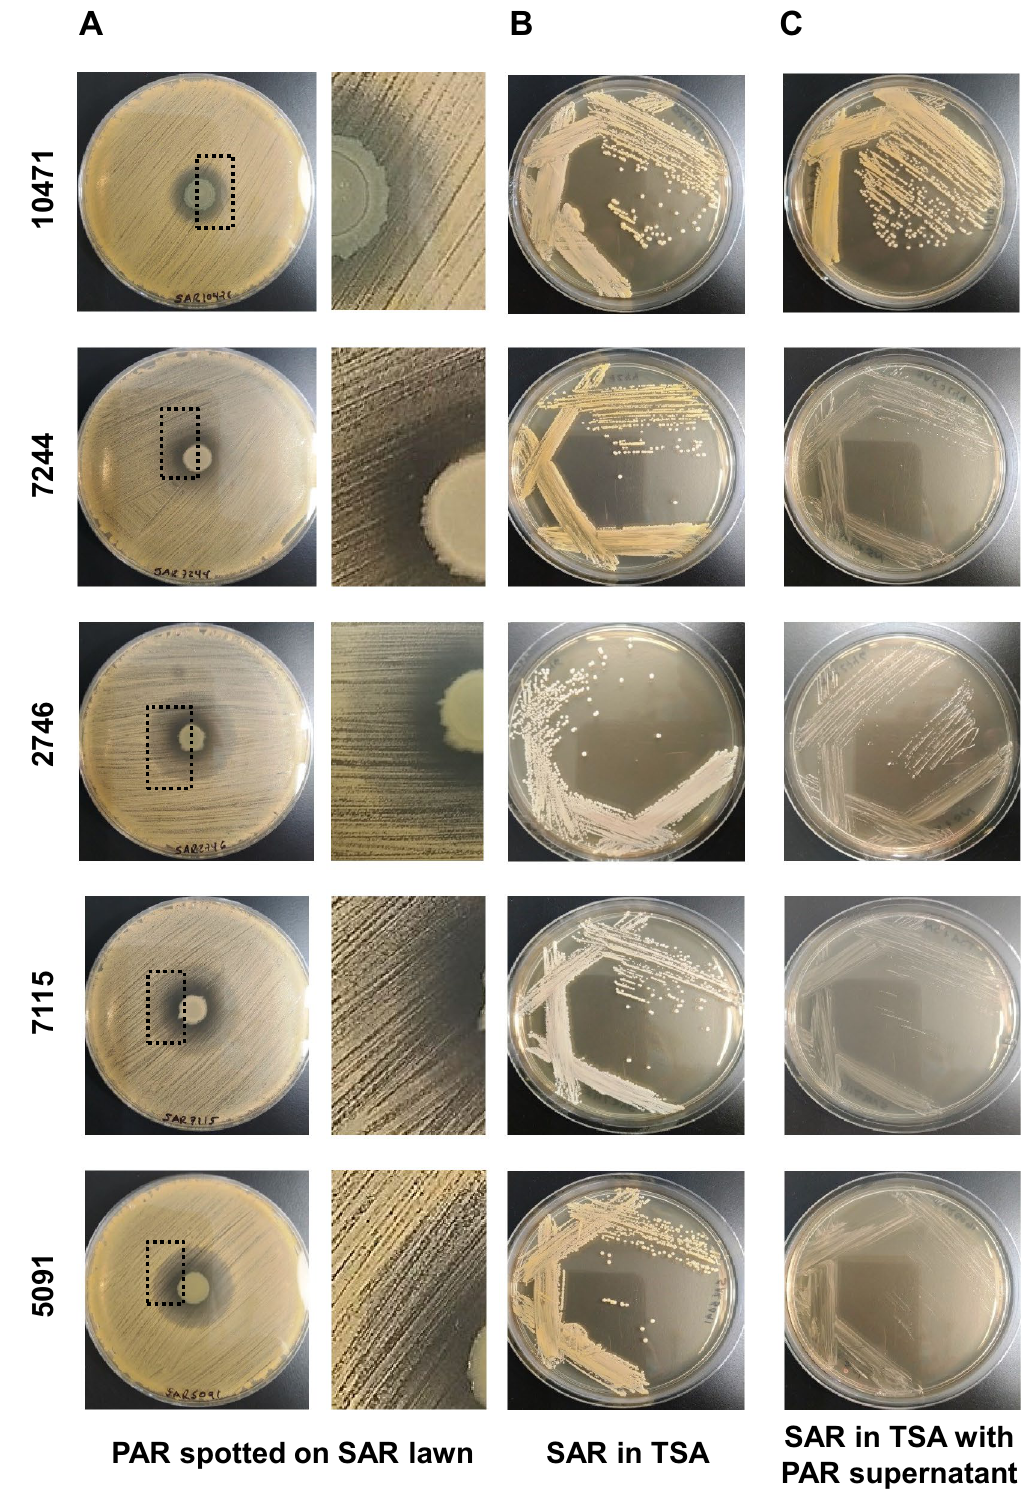
Figure 1. Interspecies growth competition assay on agar plates. ( A ) Colonies of P. aeruginosa (PAR) grown on a lawn of S. aureus (SAR) of the same co-isolated pair on tryptic soy agar (TSA) plates. Enlarged view of the boxed area is shown in the right panel. ( B and C ) S. aureus was streak-inoculated onto TSA plates with or without P. aeruginosa supernatant. Strain names are according to the origin of the sample (see Tables 1, S1 and